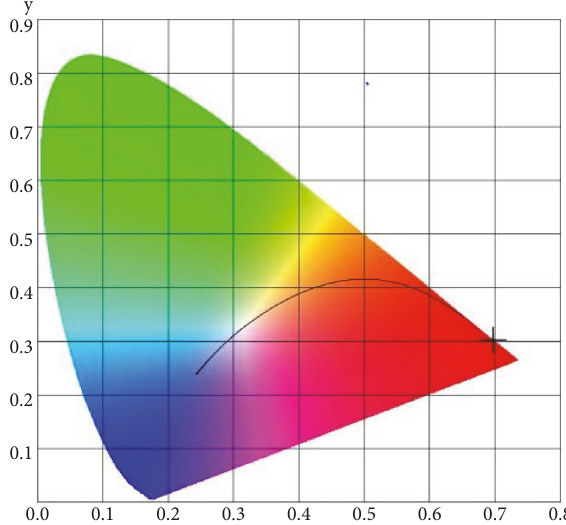
Figure 7: Chromaticity diagram.